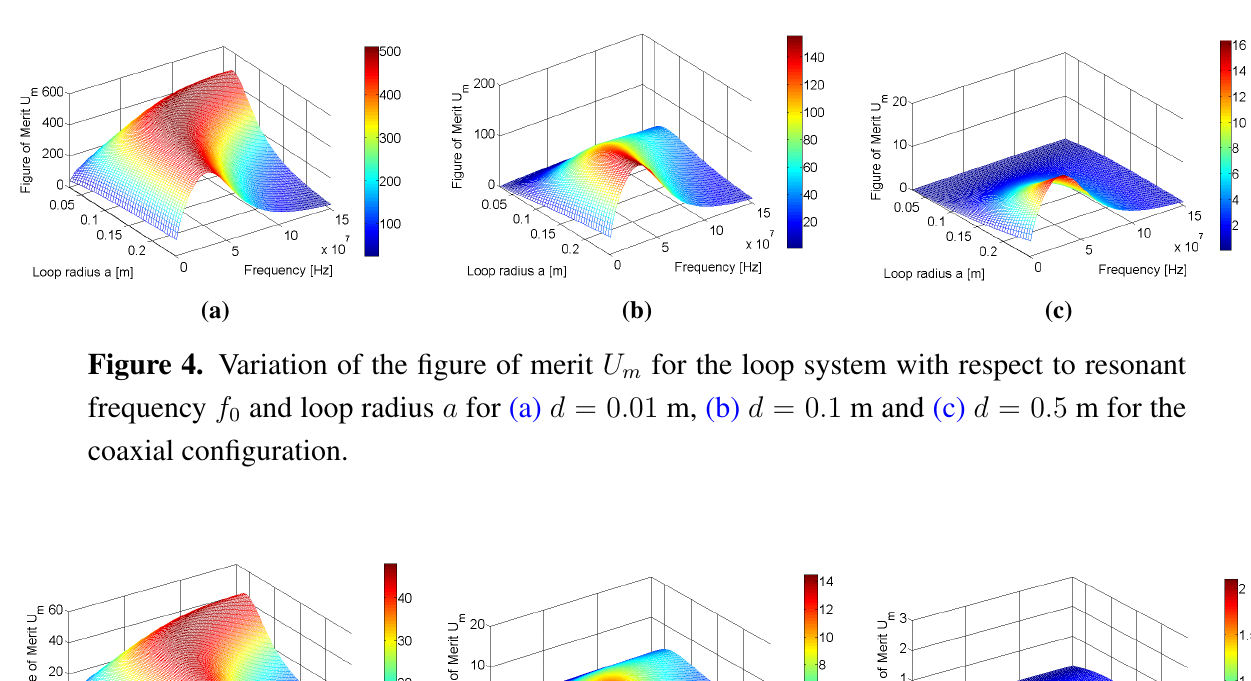
for the loop system with respect to resonant m